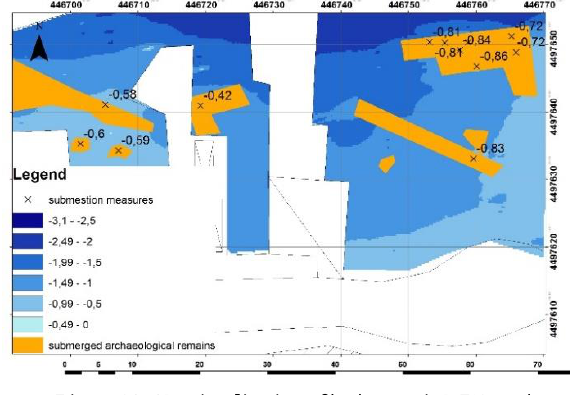
Figure 12. 2D visualization of bathymetric DEM and submersion measures of archaeological remains by means